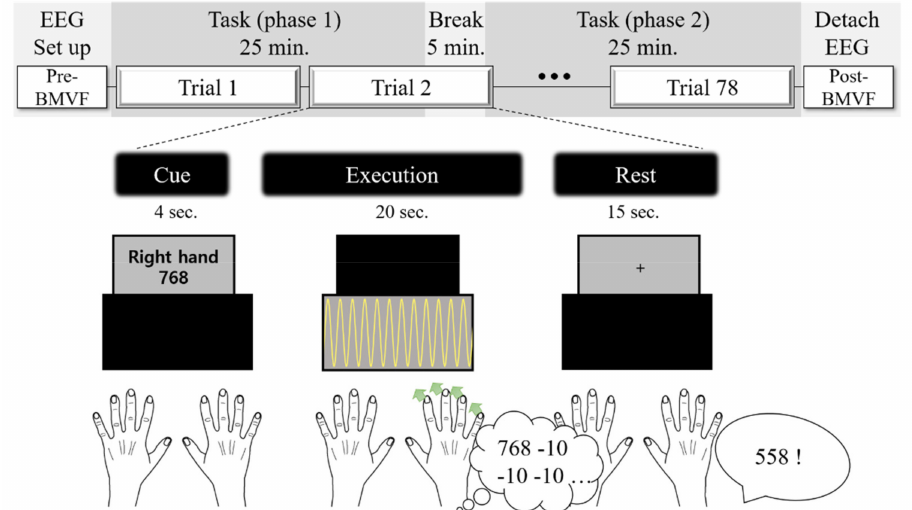
Figure 1. Schematic configuration of the experimental procedures. The top flow chart presents the timetable of the experiment from EEG setup to detachment of the device. It takes approximately 2 min to measure the BMVF before and after the task. Each trial consists of a cue (4 s), execution (20 s), and rest (15 s)